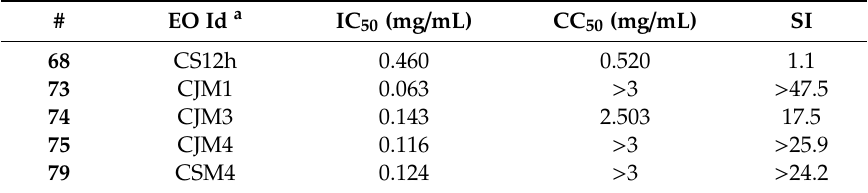
Table 5. Experimental results obtained from biological assays on the predicted samples (see